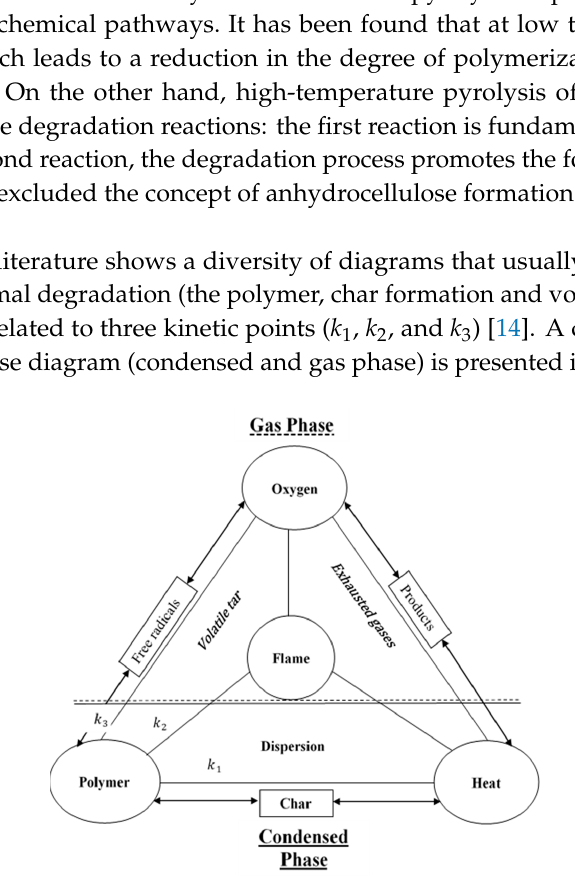
Figure 2. Concept of the combustion Emmons triangle modification [19]; kinetic points (k 1 , k 2 , k 3 ).